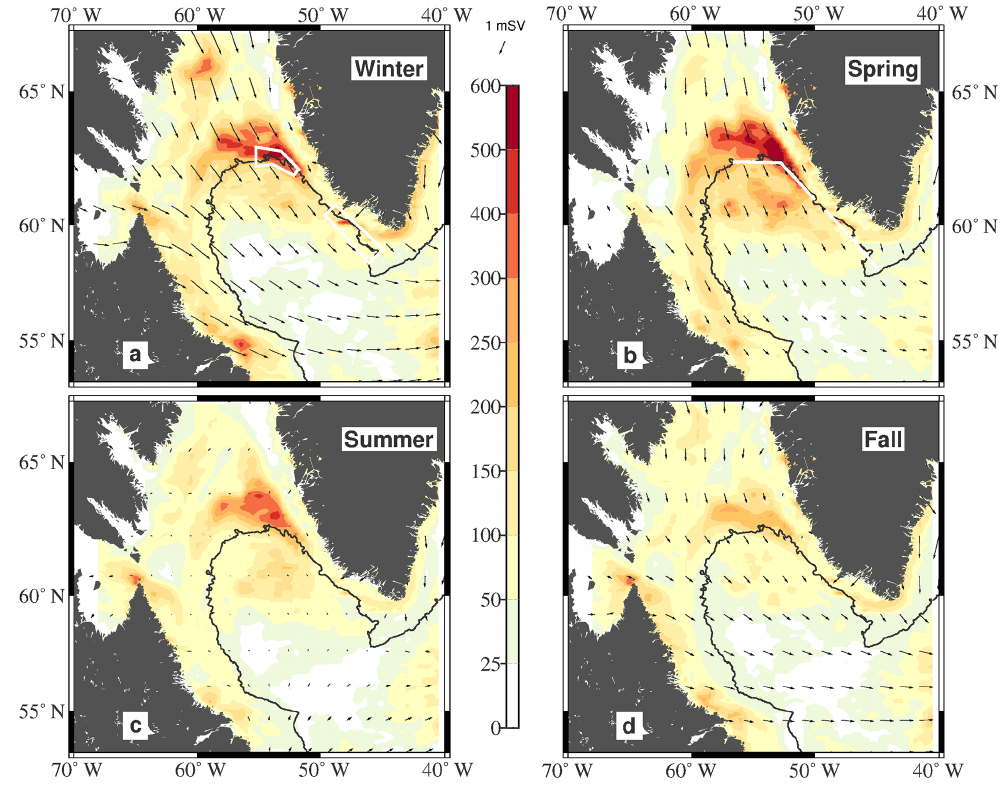
Figure 7. The 3-monthly mean of eddy kinetic energy (color, cm 2 s − 2 ) and wind (vectors, ms − 1 ) in the Labrador Sea, 1990–2009, for (a) December–February, (b) March–May, (c) June–August, and (d) September–November. The white boxes in (a) show the regions over which EKE is averaged in Fig. 8. The white lines in (b) show the sections across which Ekman transport is